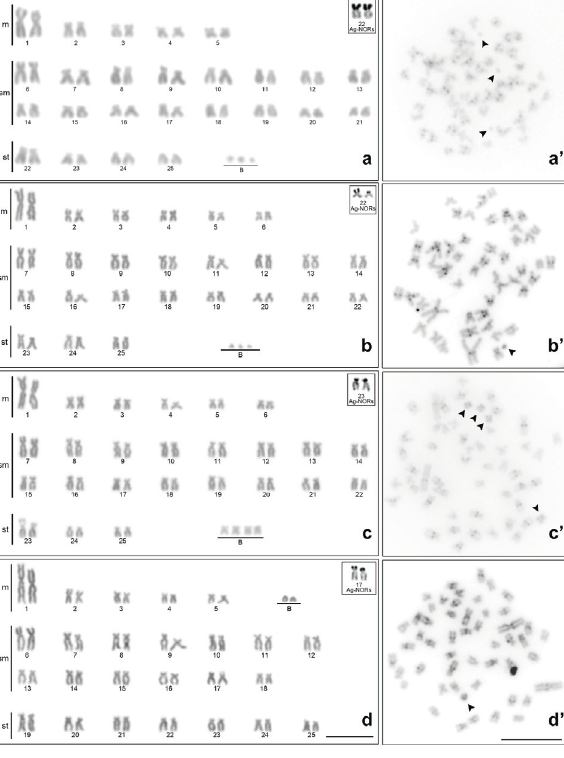
Figure 3 - Karyotypes stained by 5% Giemsa ( a , b , and c ) and the metaphases after C-banding ( a’ , b’ , and c’ ) of (a) M . forestii ; (b) M . oligolepis (Sangue River); (c) M . oligolepis (Corredeira Stream), and (d) M . oligolepis (Xapuri River). The B chromosomes (arrowheads) are shown in the insert. The Ag-NORs are represented in the box. Scale bar = 10 (cid:2) m.